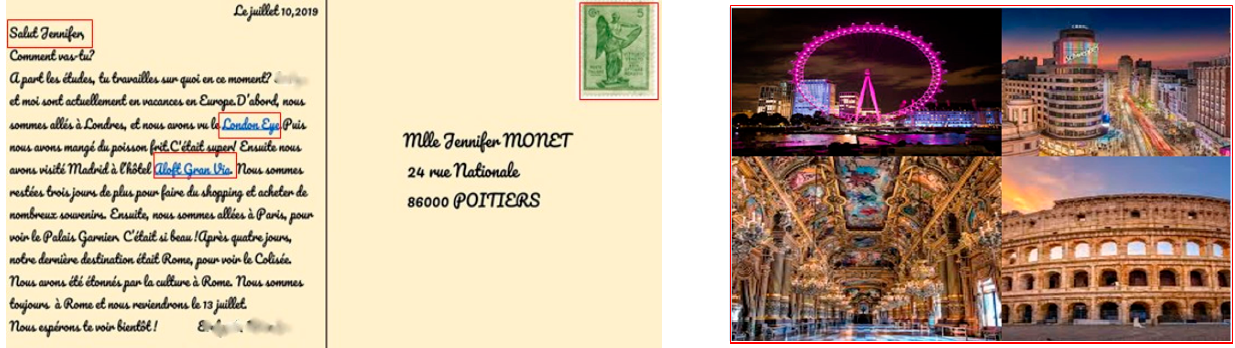
Figure 1. A screenshot of Britney and Eva’s digital postcard entitled “Un voyage touristique en Europe” (Sight-seeing in Europe).